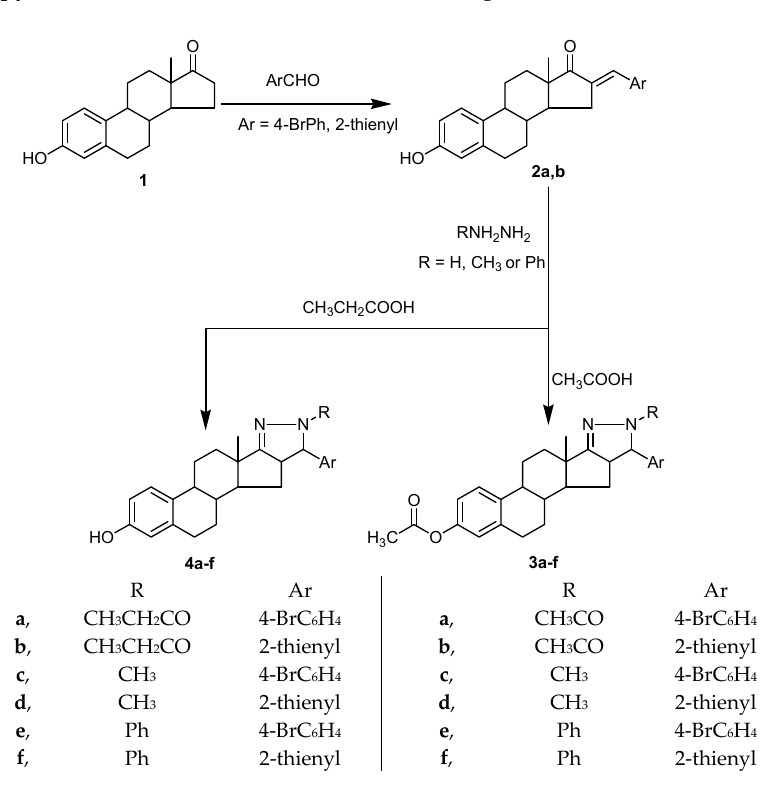
Figure 2. Synthetic route for compounds 2a , b , 3a – f , and 4a – f